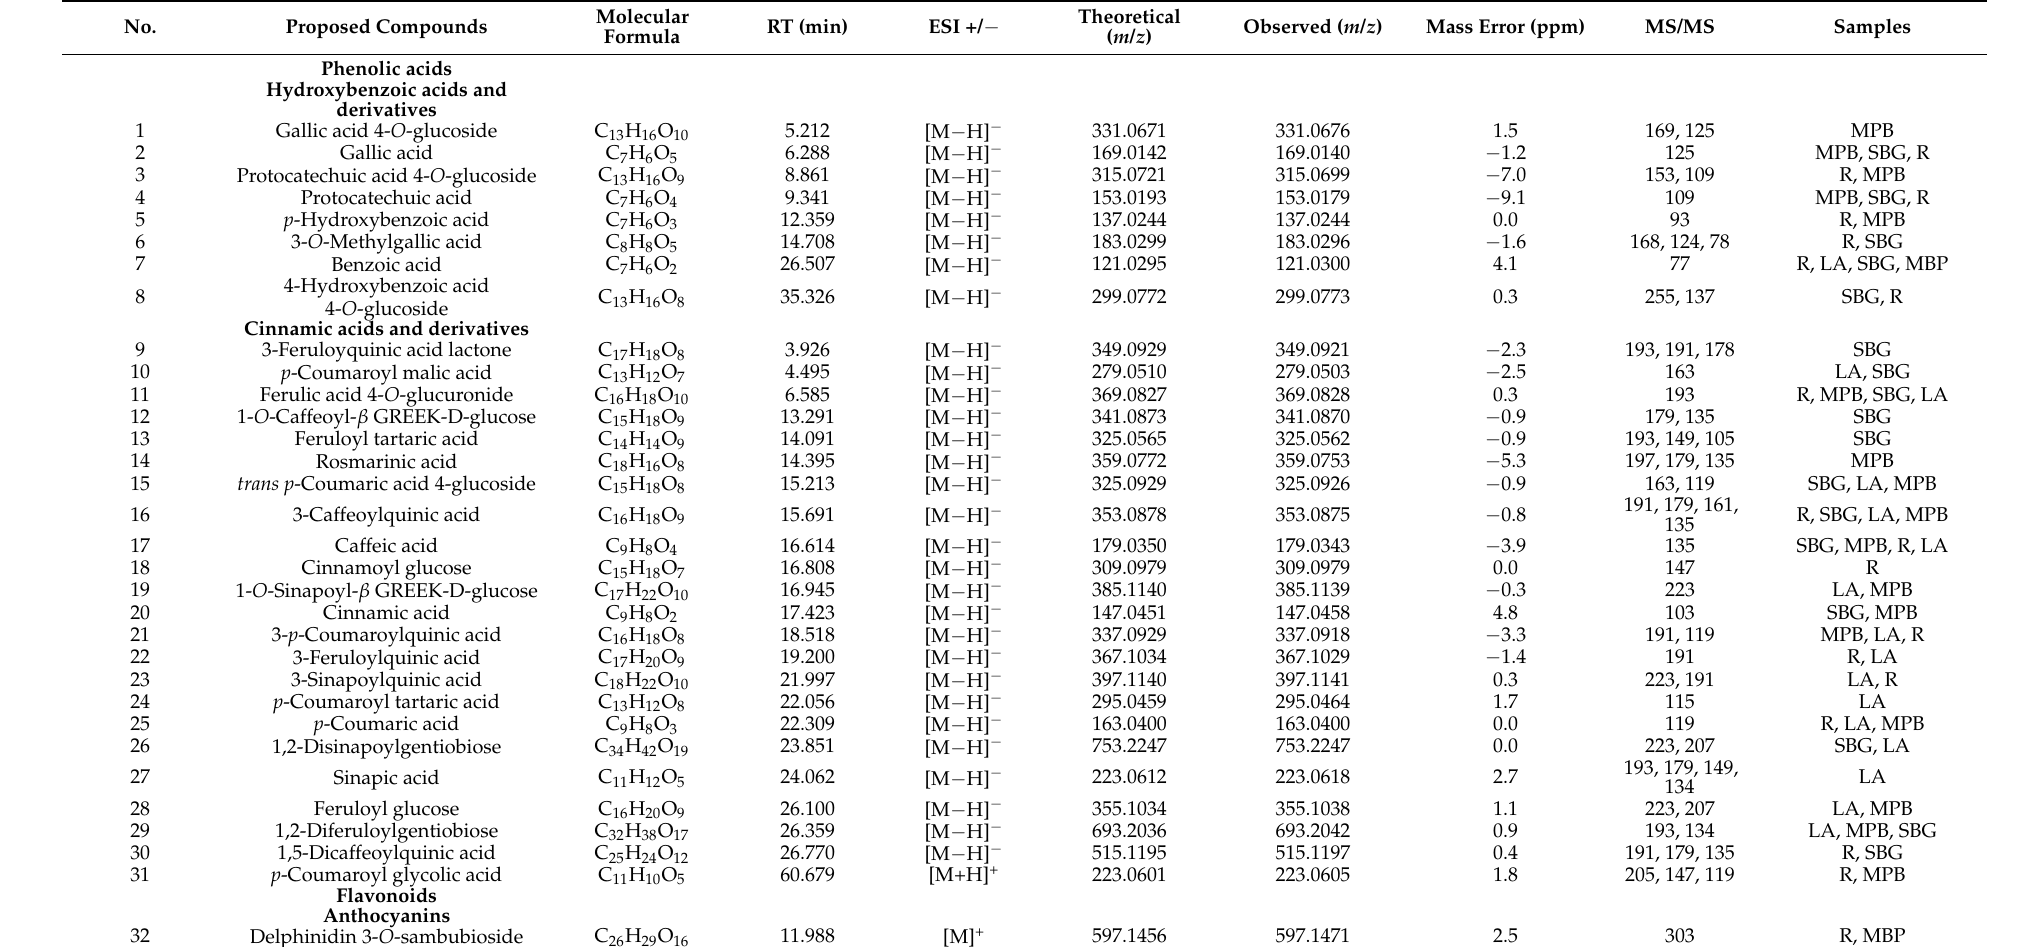
Table 3. LC-MS/MS characterization of phenolic metabolites in Australian native fruits and